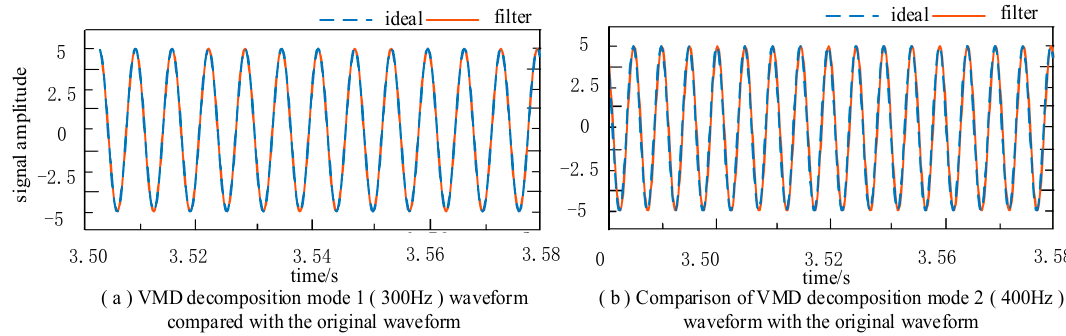
Figure 10. 300, 400 Hz VMD mode decomposition waveform and their original signal waveform comparison chart.